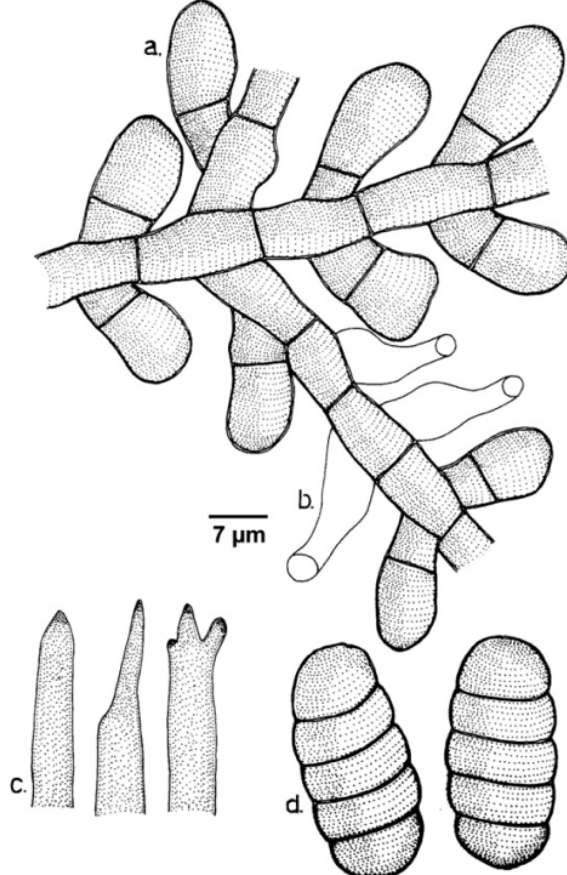
Figure 39. Meliola allophyli–concanici a - Appressorium; b - Phialide; c - Apical portion of mycelial setae;